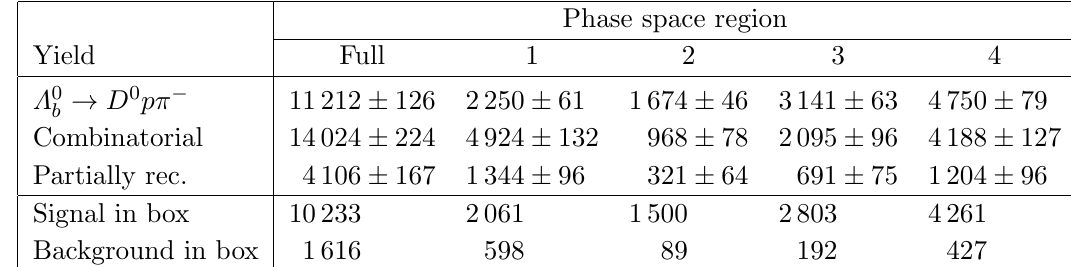
Table 1 . Results of the (cid:12)ts to the (cid:3) 0 space and in the four phase space regions used in the amplitude (cid:12)ts. The signal and background yields for the full M ( D 0 p(cid:25) (cid:0) ) range, as well as for the amplitude (cid:12)t region j M ( D 0 p(cid:25) (cid:0) ) (cid:0) m ( (cid:3) 0 30 MeV (\box"), are